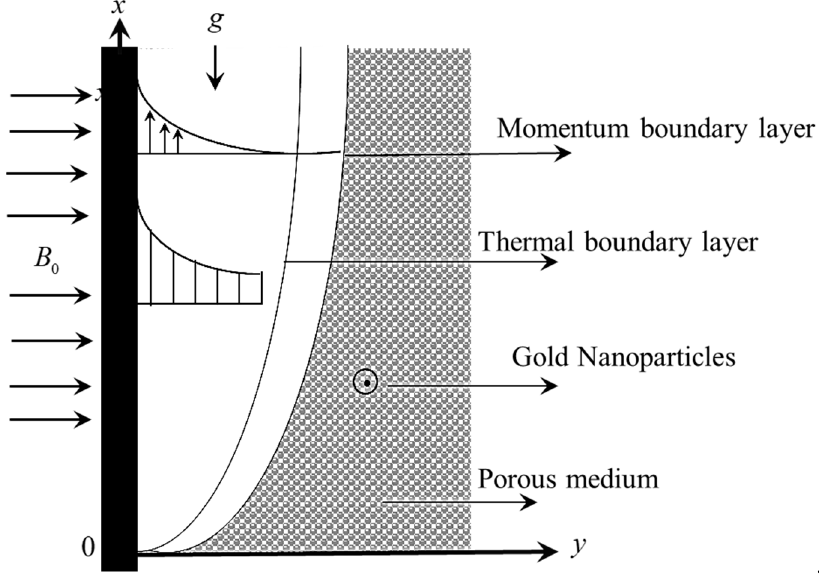
Figure 1. Physical sketch and coordinate system.